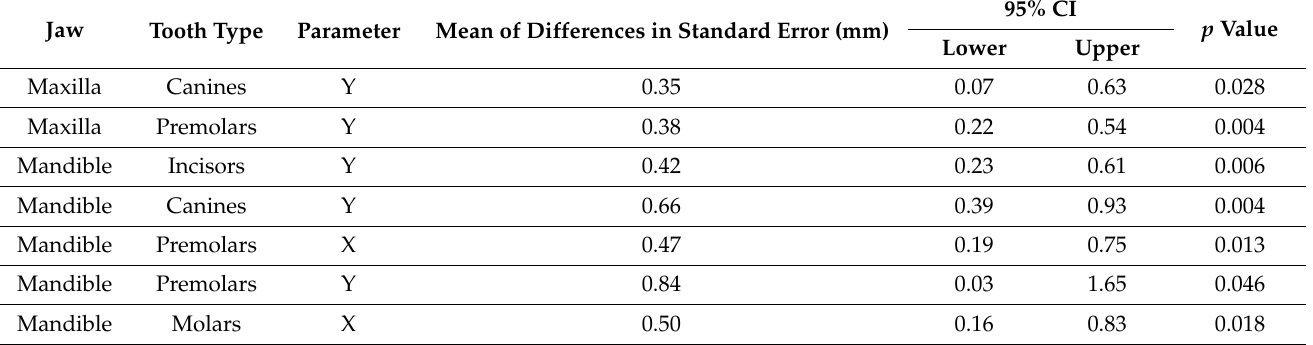
Table 3. Influence of extraction therapy on the fabrication of the setup. Only significant differences with corresponding parameter are shown.